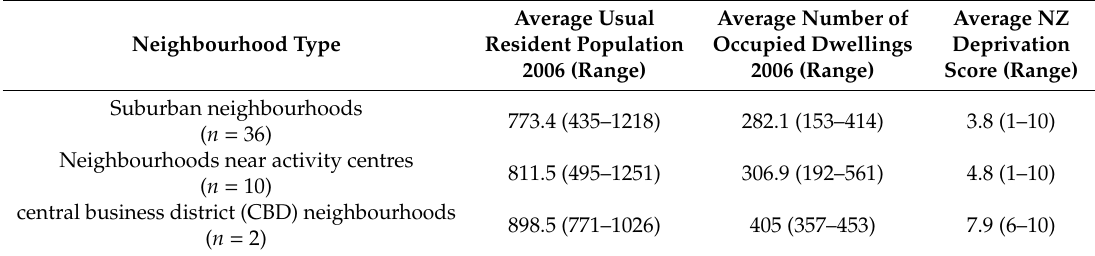
Table 1. Summary of neighbourhood